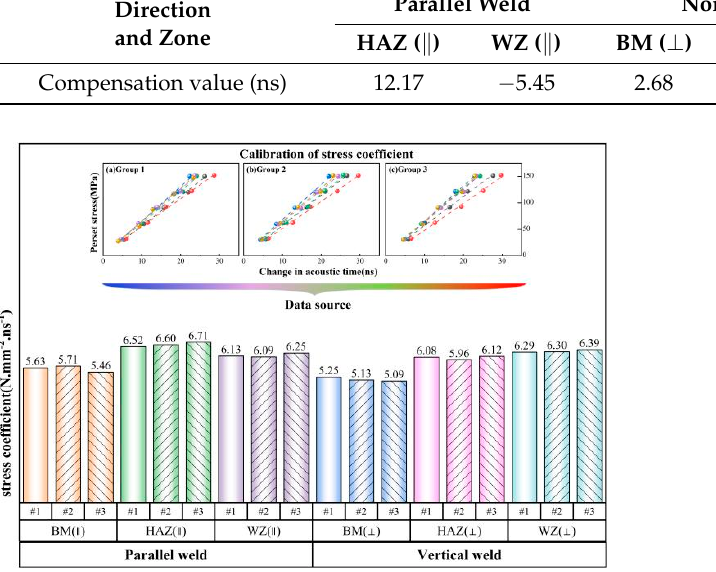
Figure 4. Calibration of stress coefficient.